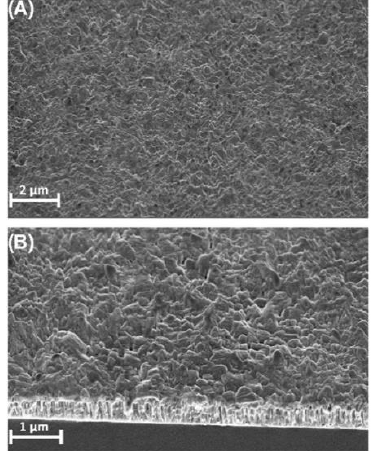
Figure 8. Morphology of a BFO thin film: ( A ) 2 µm; (B) 1 µm [25]. BFO thin films demonstrate different crystallographic orientations based on ration of lattice parameters with various orientation, with ration angles being 71 ◦ , 109 ◦ and 180 ◦